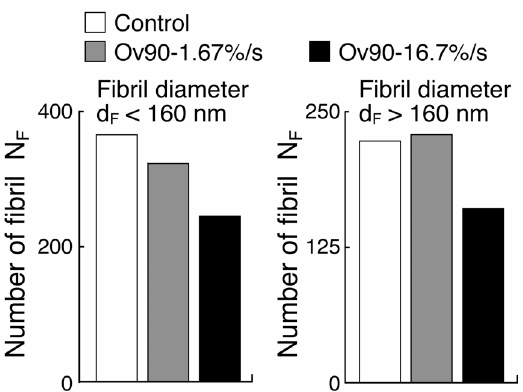
Fig. 7 Number of collagen fibrils having a diameter of above or blow 160 nm in total visualized area of the control and overloaded